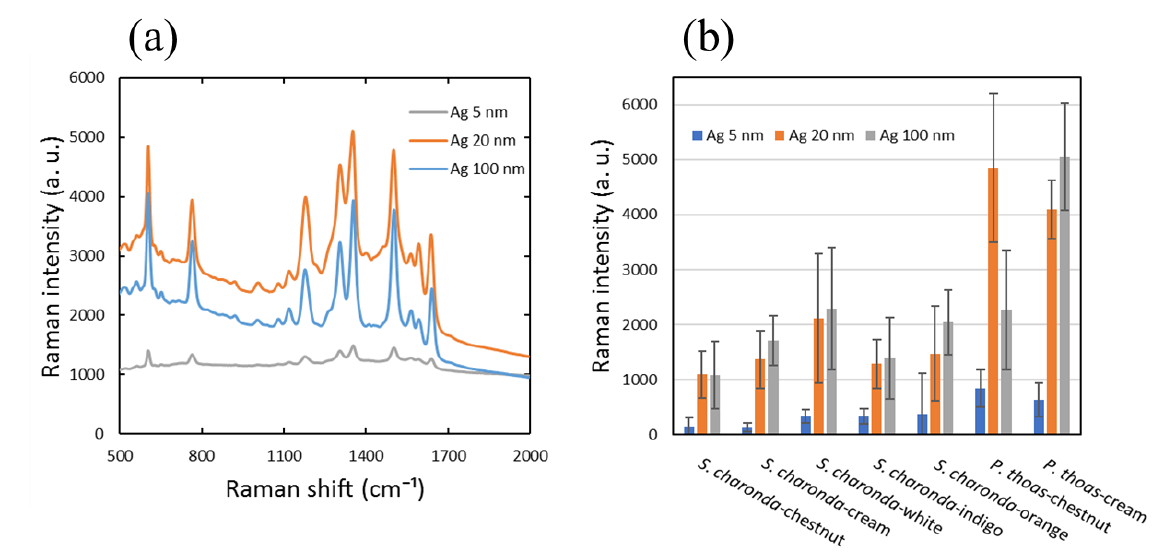
Figure 3. SERS activities of various scales of S. charonda and P. thoas. ( a ) SERS spectra of 1 mM R6G from chestnut scales of S. charonda , with 5, 20 and 100 nm silver deposition. ( b ) Bar graph summarizing intensities of the 774 cm − 1 band from chestnut, cream, white, indigo, and orange scales of S. charonda, and chestnut and cream scales of P. thoas . Spectra from which the intensities were calculated are shown in Figure A2.